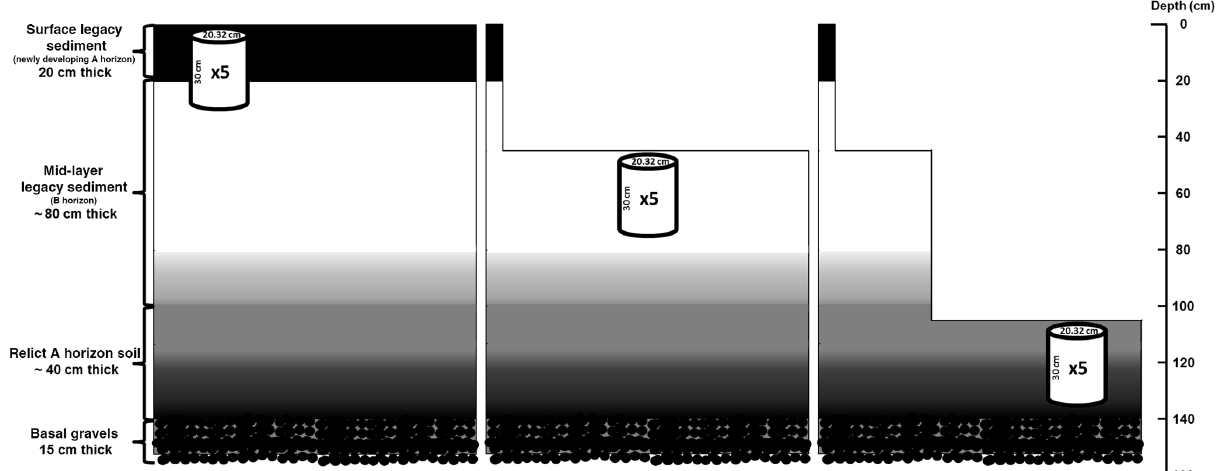
Figure 1. Stepwise sampling scheme used for soil core collection at Big Spring Run. Five intact soil cores (20.32cm diameter and 30cm length) were collected for each of the three soil horizons of interest (surface legacy sediment, mid-layer legacy sediment, and relict A horizon soil). Surface legacy sediment cores were collected in one area, then the surface legacy sediment was removed from an adjacent area to sample the underlying legacy sediment, and then finally the surface and mid-layer legacy sediment were removed from a third adjacent area to sample the underlying relict A horizon